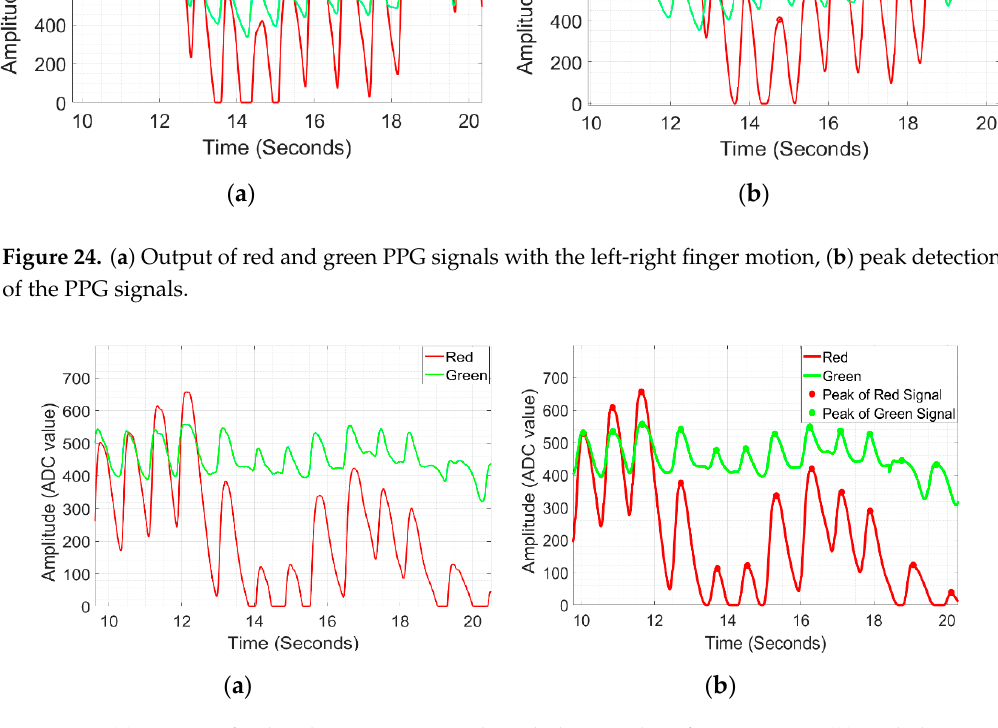
Figure 25. ( a ) Output of red and green PPG signals with the round ‐ up finger motion, ( b ) peak detection of the PPG signals.